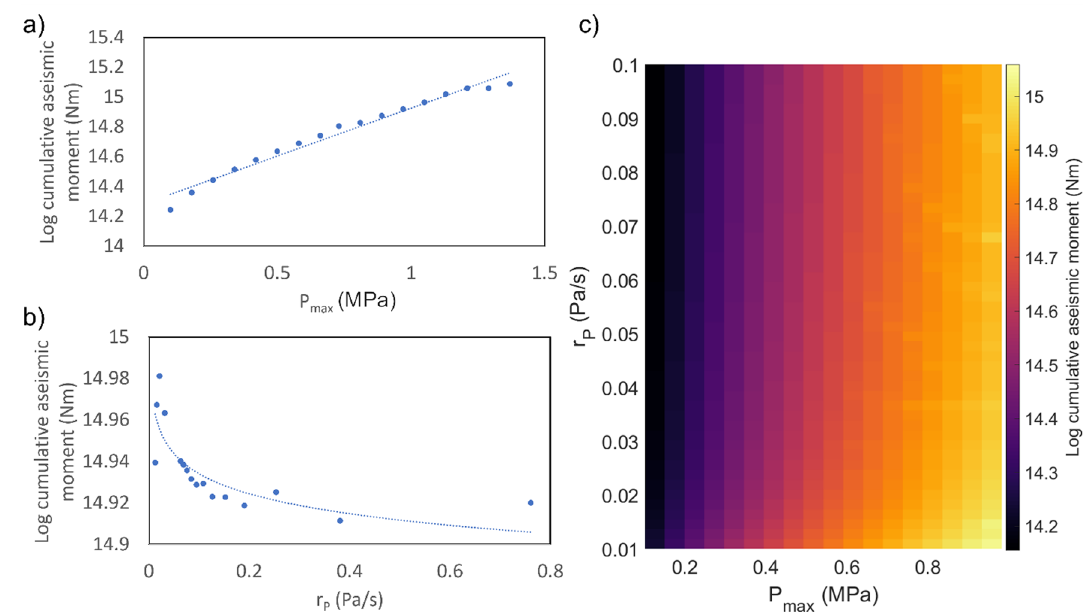
Figure 3. Aseismic response of the fault under pore-pressure perturbation. ( a ) Cumulative aseismic moment released during perturbation versus P max for category 1 at r P = 0.07 Pa/s. ( b ) Cumulative aseismic moment released during perturbation versus r P for category 1 at P max = 1 MPa. ( c ) Cumulative aseismic moment released during perturbation (colour scale) vs P max vs r P